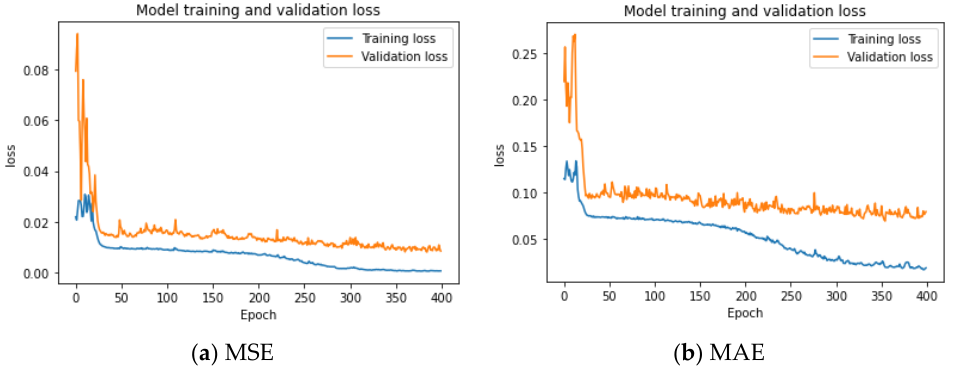
Figure 8. Training and validation loss function graph of the RWE–LSTM modeling process with ( a ) the Mean Squared Error loss function and ( b ) Mean Absolute Error loss function. Table 1. Normal distributions for five levels of the RWE prediction errors.